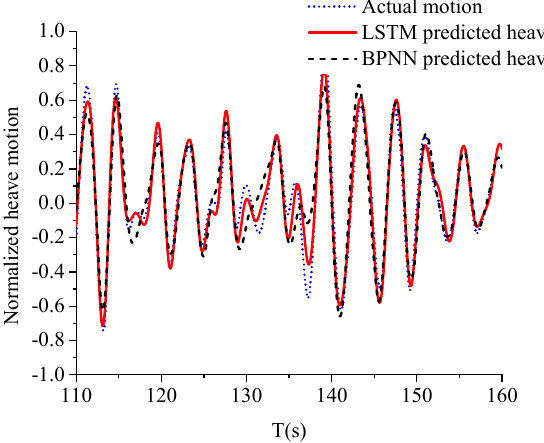
Figure 13. Prediction results of the heave structure motion in irregular waves. The sampling frequency of the height meter is 100 Hz. The recorded heave motion is curved in the upper subfigure of Figure 14. The reference heave motion is normalized as the regular motion case. The discussion in this section is separated into two parts. The first part determines the optimal feedforward step of the PID control system, and the second part compares the performance of the control system when the two machine learning prediction algorithms are used.